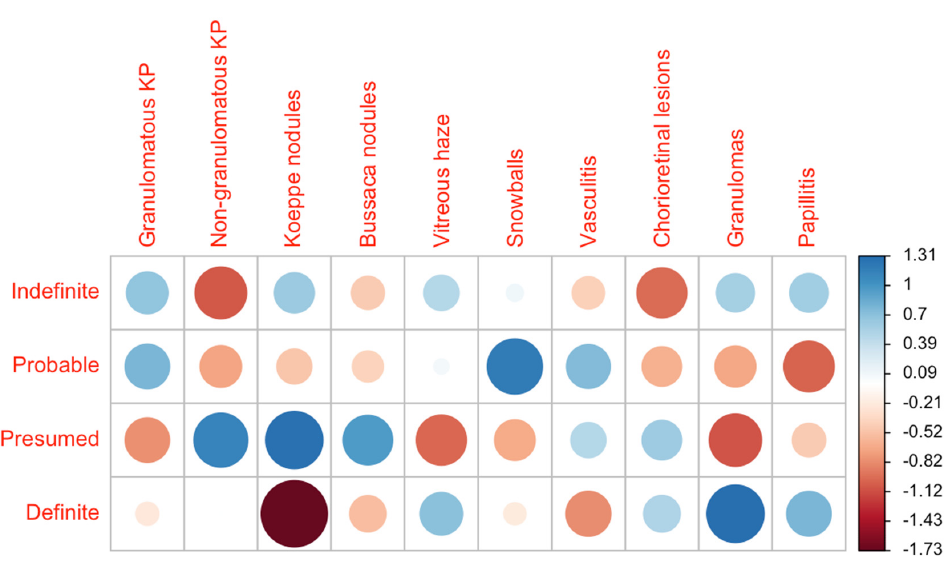
Figure 2. Distribution of the single ocular manifestations across the diagnostic groups. The data are presented as a correlation matrix. The blue color represents a higher-than-expected probability of occurrence, and red represents a lower probability. KP = keratic precipitates. The larger the circles, the higher the deviation from the expected value given a homogeneous distribution across all groups.